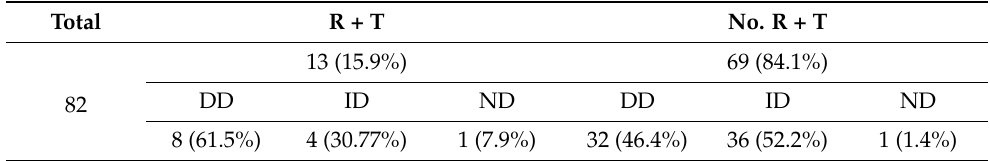
Figure 12. The graph shows all cases of II–III–IV degree burns divided into the following two groups: immediate deaths and delayed deaths. For each group, the cause of death is indicated. Both radiological and toxicological analyses were employed in 13/82 (15.2%) cases. However, in the remaining 69, only one or neither examination was performed. Of the subjects who underwent both radiological and toxicological examinations, direct diagnoses were made in 61.5% of cases, compared with 46.4% of cases in which direct diagnoses were not made. On the other hand, in the cases in which the examinations were not performed or were performed only partially, the indirect diagnoses correspond to 36/82 cases, or 52.2%. On the other hand, in the cases in which they were performed, the percentage is 30.7% (Table 8 and Figure 13). Table 8. The table shows the number of cases (and percentage) of subjects undergoing or not undergoing both radiological and toxicological examinations. The data were then matched with diagnostic findings. Here, DD indicates “direct diagnosis”; ID indicates “indirect diagnosis”; ND indicates